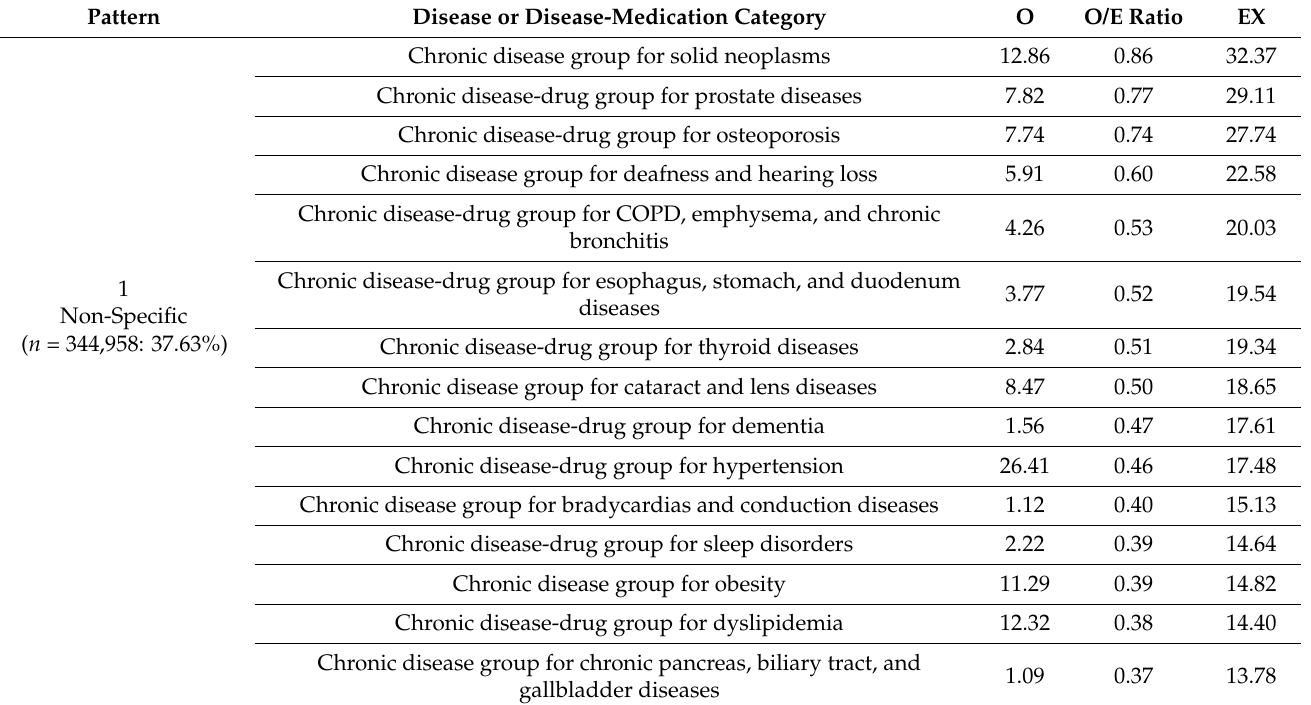
Table 1. Most frequent 15 chronic disease or chronic disease-drug categories in individuals aged 65–99 years by cluster ( n = 916,619, Catalonia, 2012).